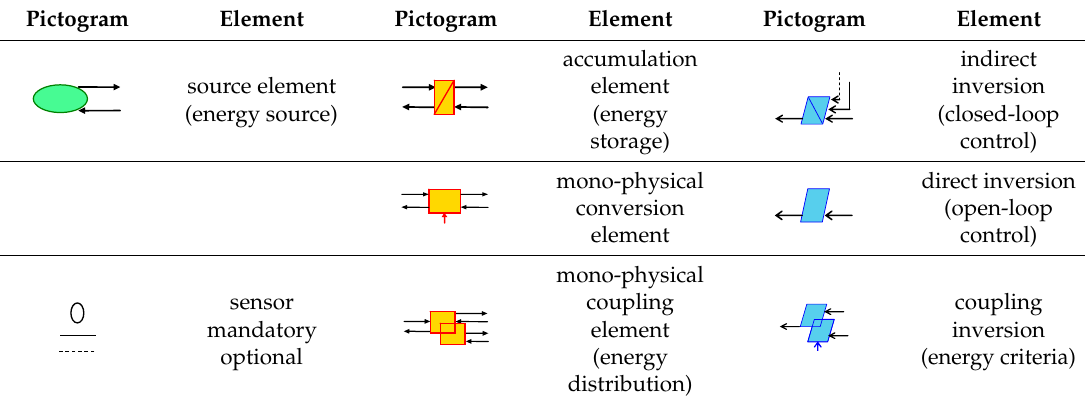
Table A1. Pictograms of energetic macroscopic representation (EMR).